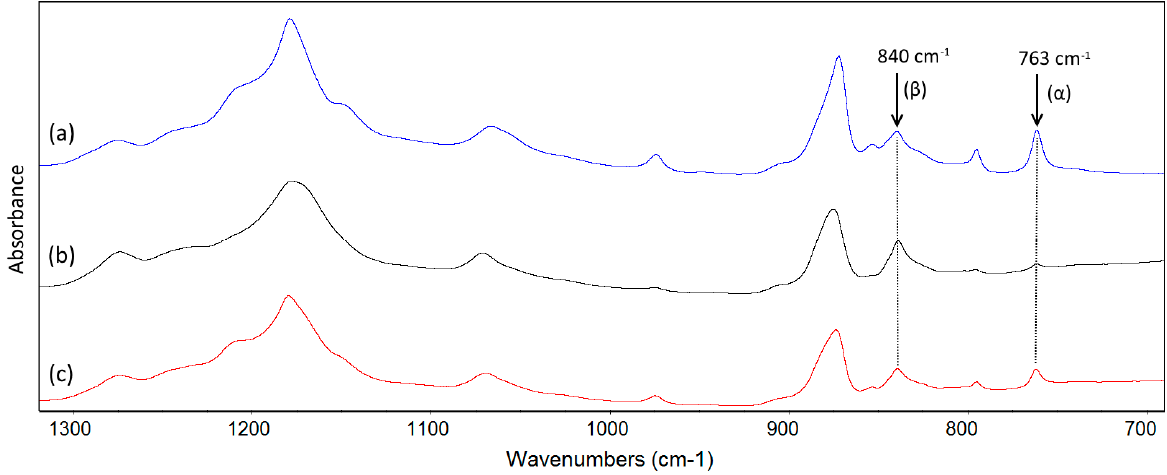
Figure 9. FTIR spectra of ( a ) PVDF membrane prepared at 25 °C, and PVDF − TiO 2 membranes prepared at ( b ) 25 °C and ( c ) 50 °C.